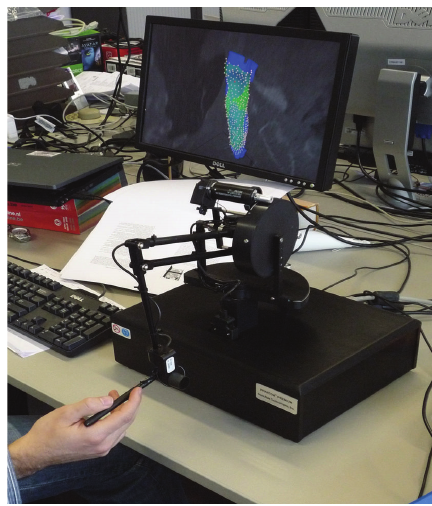
Figure 5: The set-up used to perform ACM segmentation for tra- cheal stenosis using a Phantom premium